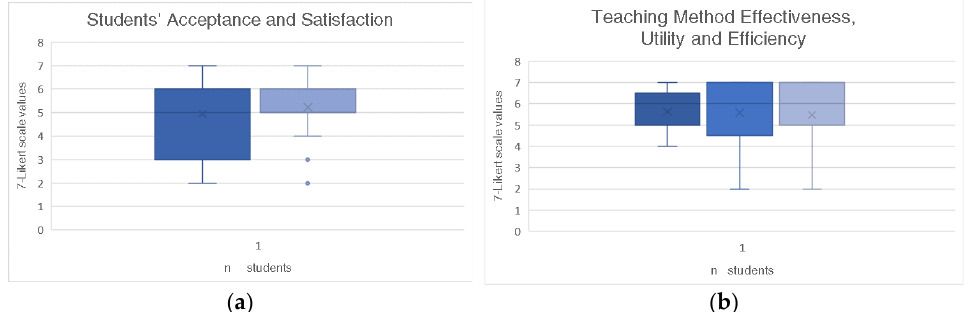
Figure 13. ( a ) Results in terms of student’s acceptance and satisfaction with the teaching method; ( b ) results in terms of the effectiveness, utility, and efficiency of the teaching methodology. Out of the sample of n = 27, only n = 8 responded to the open question. Responses were heterogeneous and reported as follows: the GUI to validate it or not;